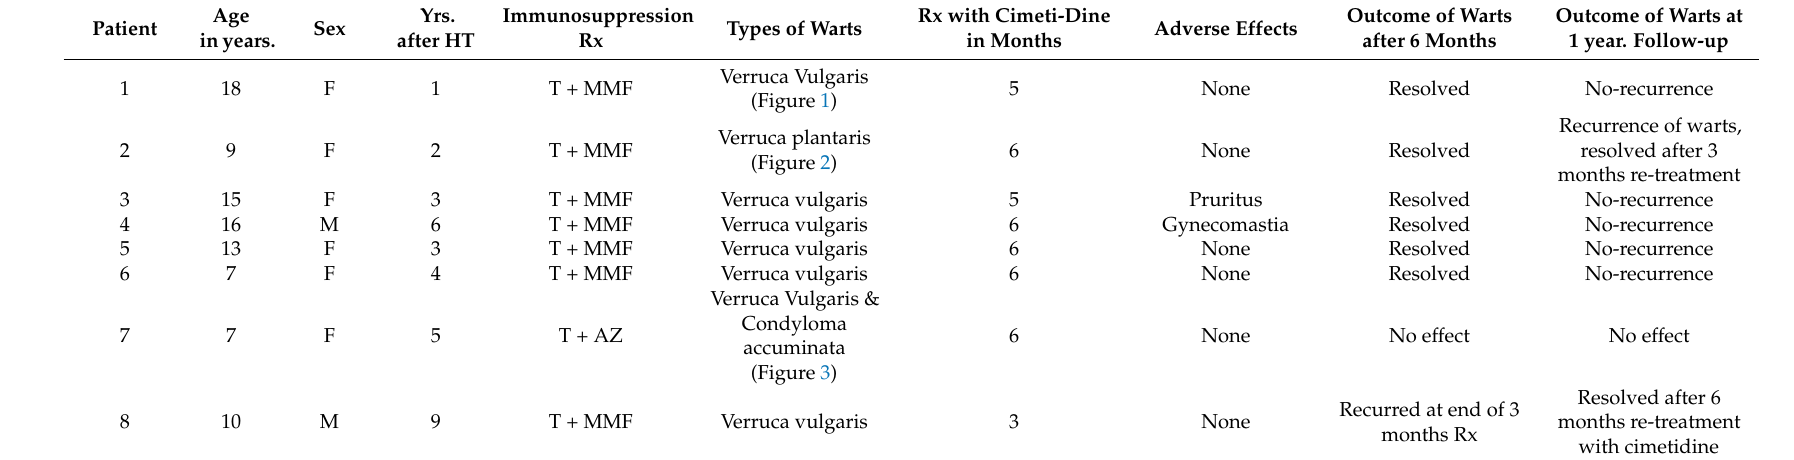
Table 1. Clinical